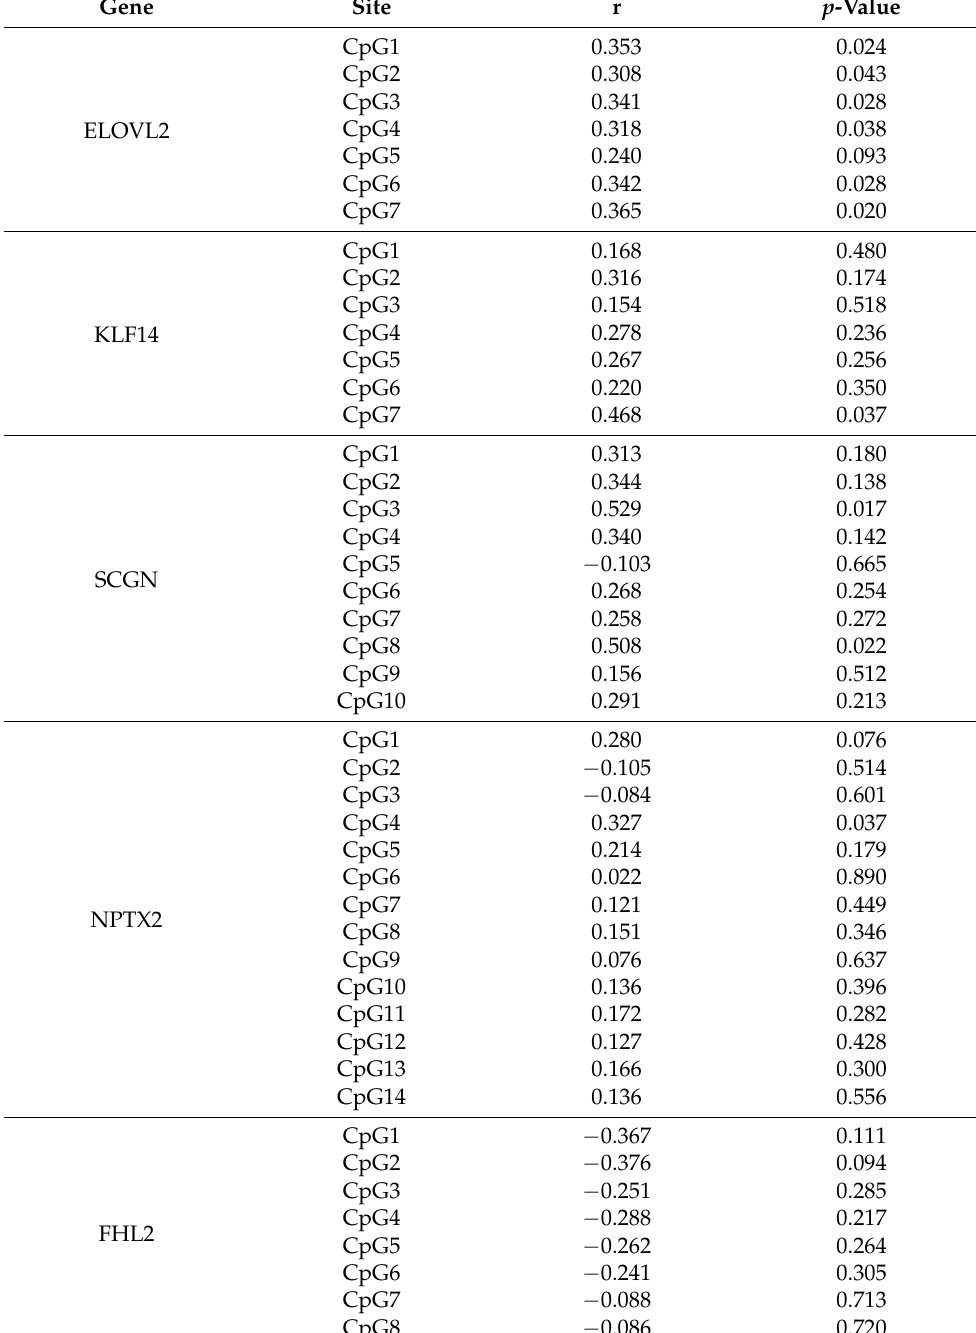
Table 1. Correlation coefficients and significance of CpG sites identified in ELOVL2, KLF14, SCGN, NPTX2, and